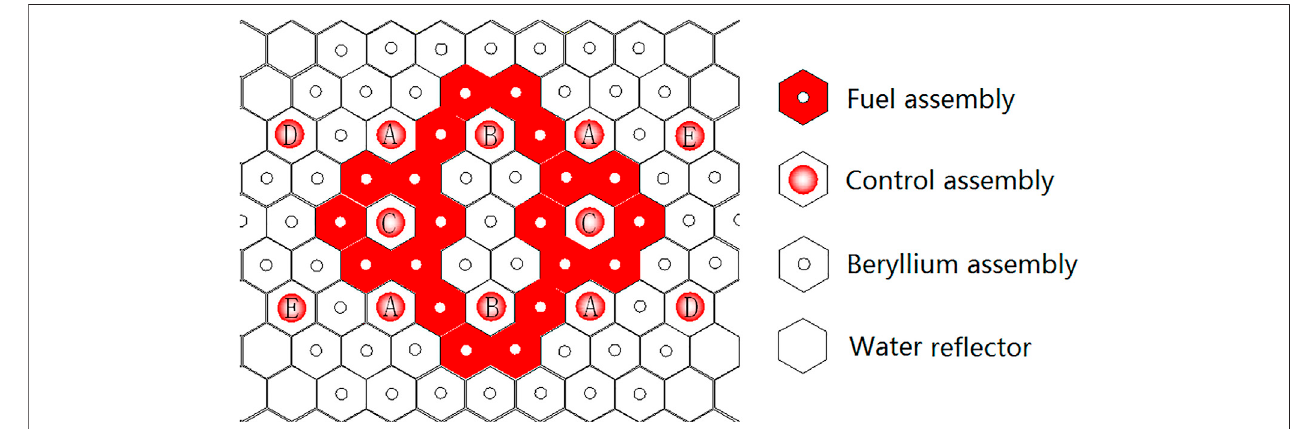
FIGURE 3 | Layout of core and control rods in Scheme 7 (layout and grouping of type 3 control rods).